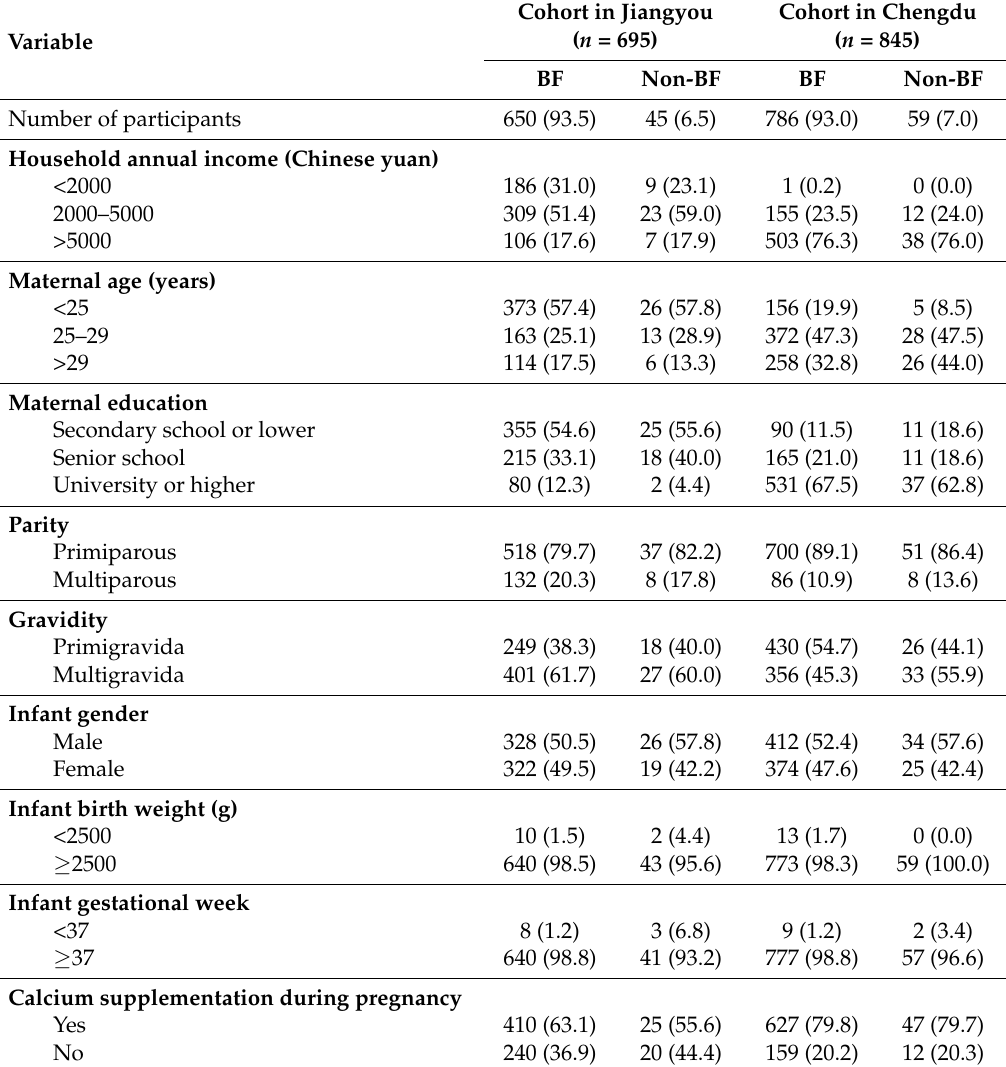
Table 2. Characteristics of participants at baseline by breastfeeding